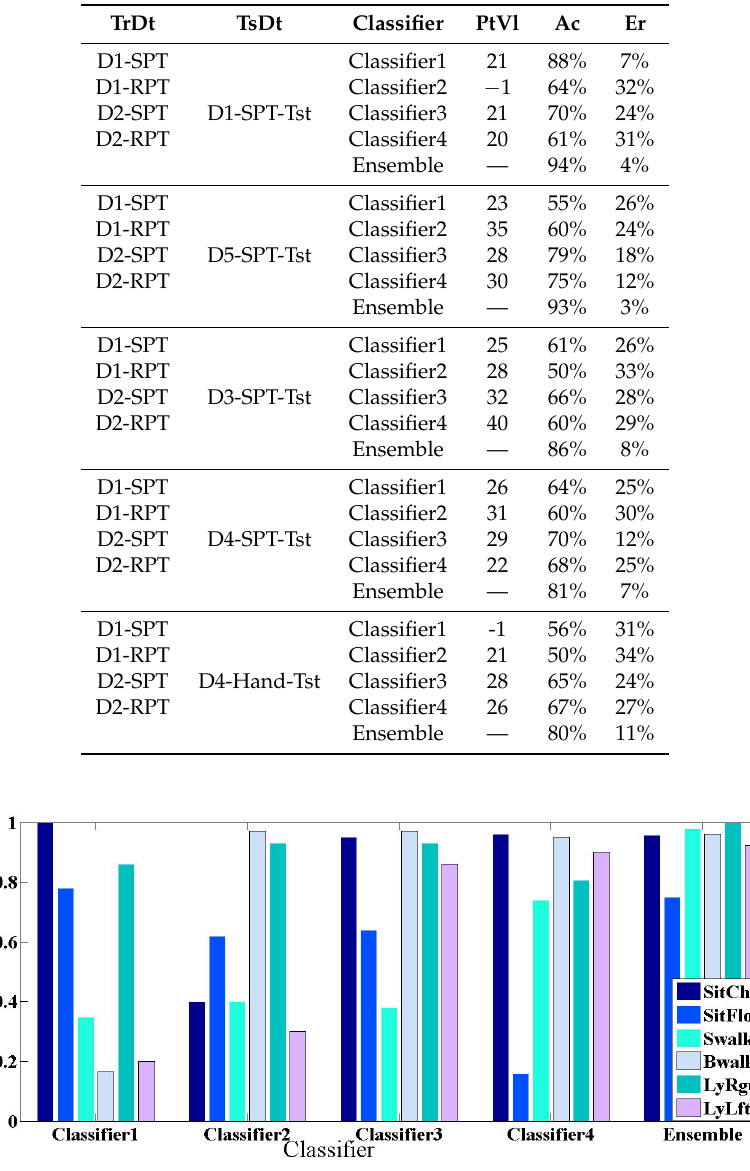
Figure 11. Classification accuracy (activity wise) for device independent activity recognition when D5 is used as a test device using condition-based and ensemble classifiers for both an accelerometer and a